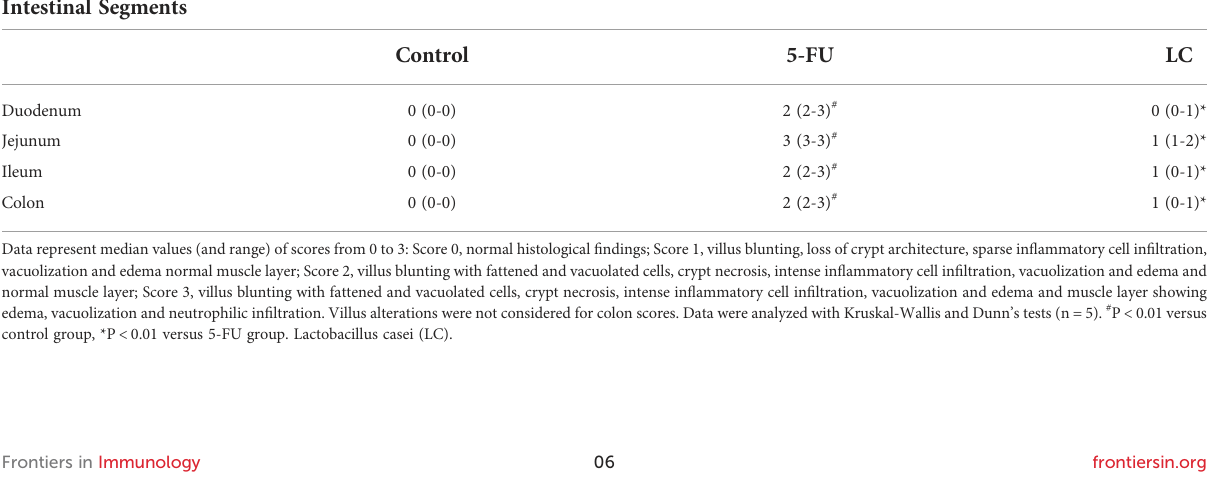
TABLE 2 Histological scores for intestinal mucositis. Intestinal Segments